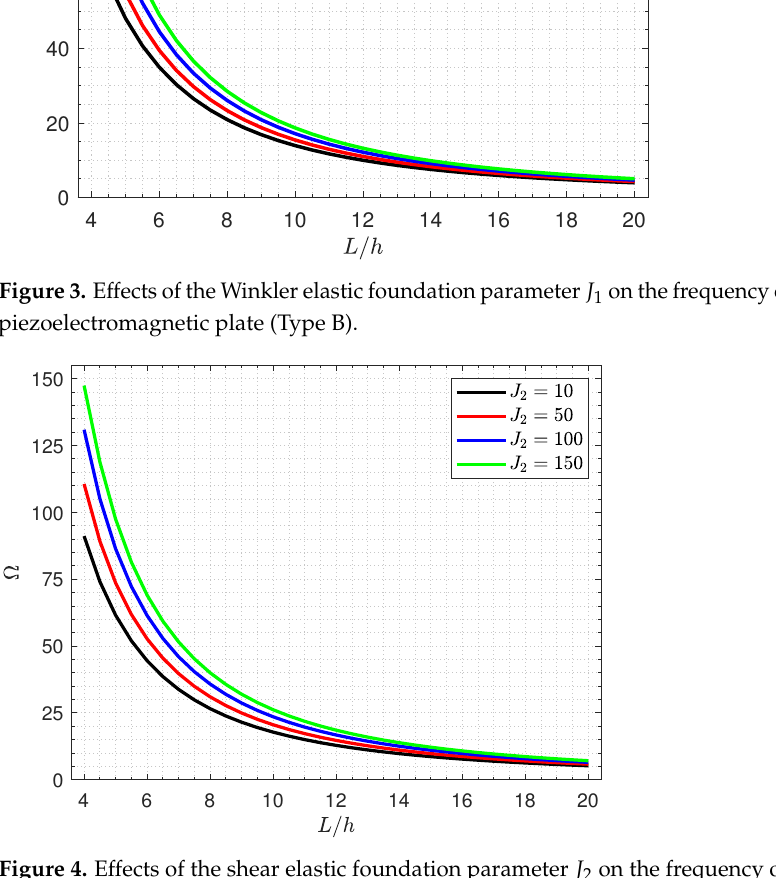
Figure 4. Effects of the shear elastic foundation parameter J 2 on the frequency of the nanocomposite piezoelectromagnetic plate (Type